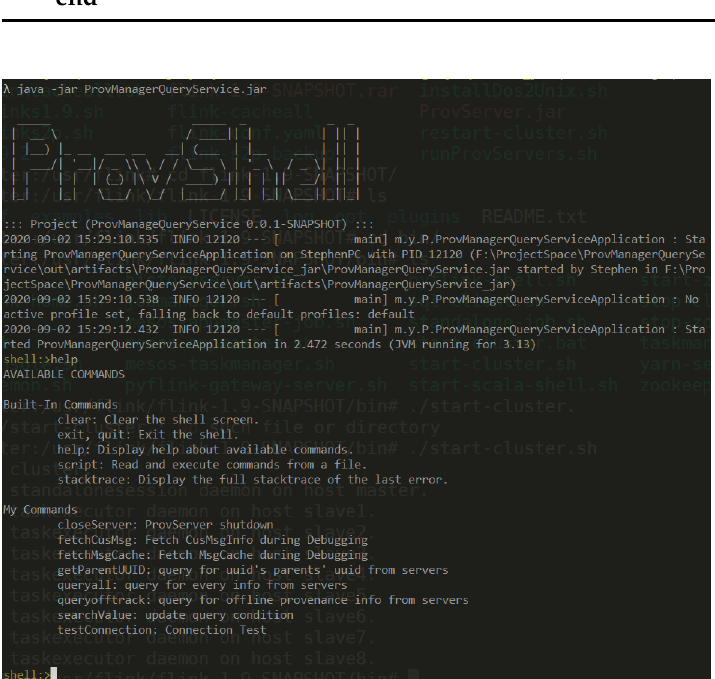
Figure 10. CLI for ProvMangerQueryService. It provides commands controlling ProvServer (e.g., clos- eServer) and query commands (e.g., getParentUUID) to answer